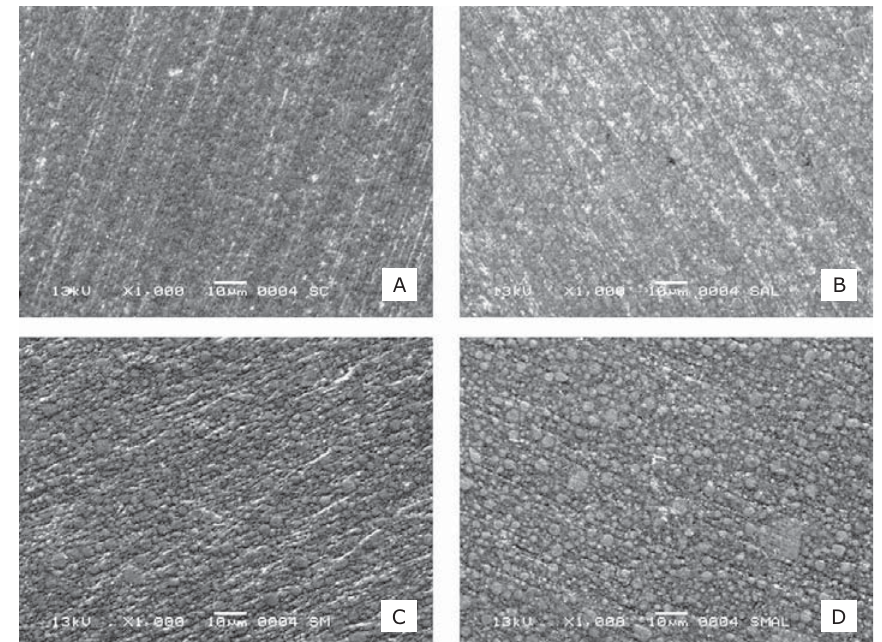
Figure 4- Changes on the morphology of Filtek Supreme evaluated by scanning electron microscopy: Control (A); Immersion in ethanol (B); Toothbrush abrasion (C); Toothbrush abrasion after immersion in ethanol